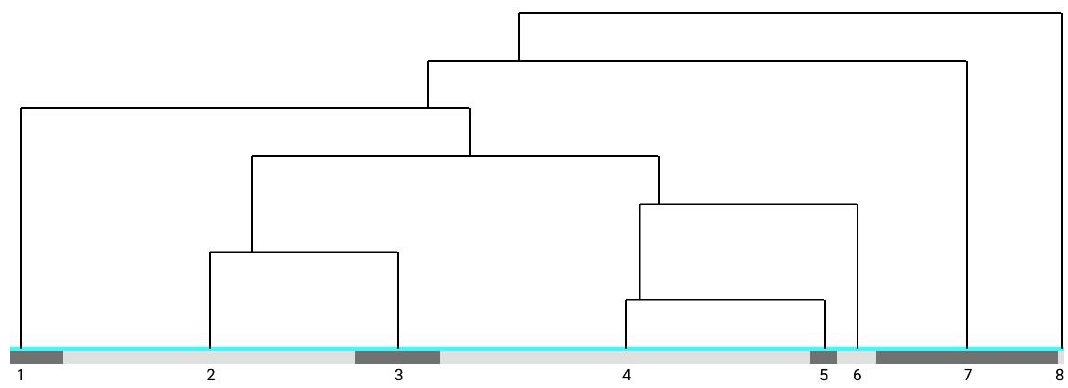
Fig. 6. Cluster analysis of the phytosociological data of the class Isoëto-Nanojuncetea Clusters mark association: 1 – Cyperetum flavescentis , 2 – Eragrostidetum suaveolentis , 3 – Veronico anagalloidis-Lythretum hyssopifoliae , 4 – Stellario uliginosae-Isolepidetum setaceae , 5 – Cyperetum michelliani , 6 – Juncetum bufonii , 7 – Pulicario